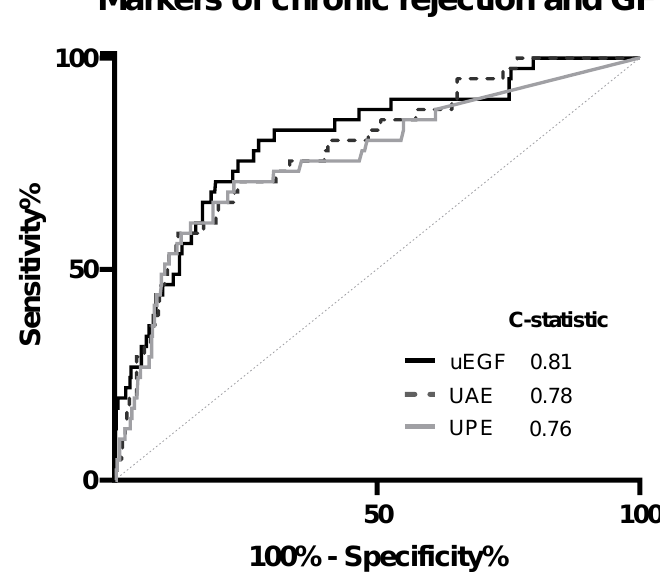
data. Model 2: adjusted for age, sex, and renal transplant recipient characteristics. Model 3: Model 1 + Model 2. Model 4: adjusted for age, sex, and immunosuppressive therapy. Model 5: adjusted for age, sex, and eGFR and urinary protein excretion. Model 6: model 4 + model 5. RTRs, renal transplant recipients; uEGF, urinary epidermal growth factor.